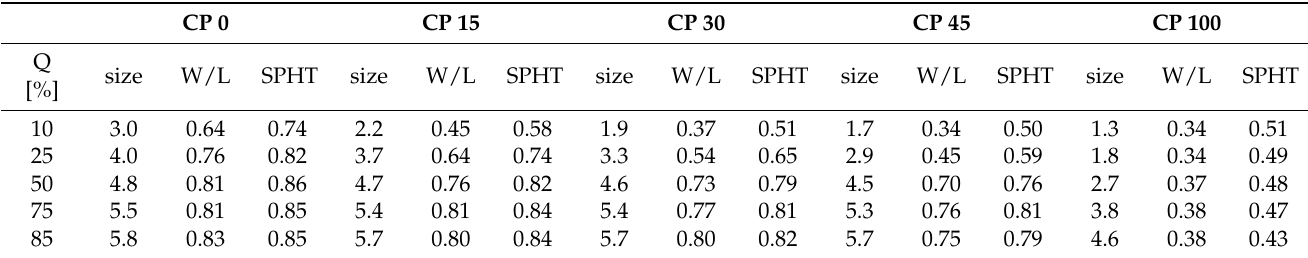
Table 3. Development of aggregate size [mm], aspect ratio ( W / L ), and sphericity (SPHT, normalized) with increasing cumulative size distribution (Q [%]) of aggregate size (equivalent circle radius) at CP